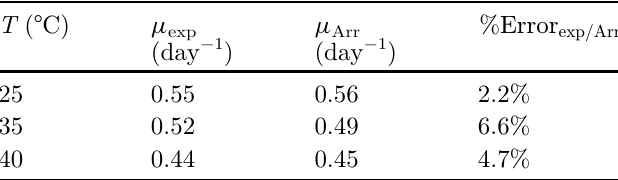
Table 2. A comparison between experimental and predicted maximum speci fi c growth rates.